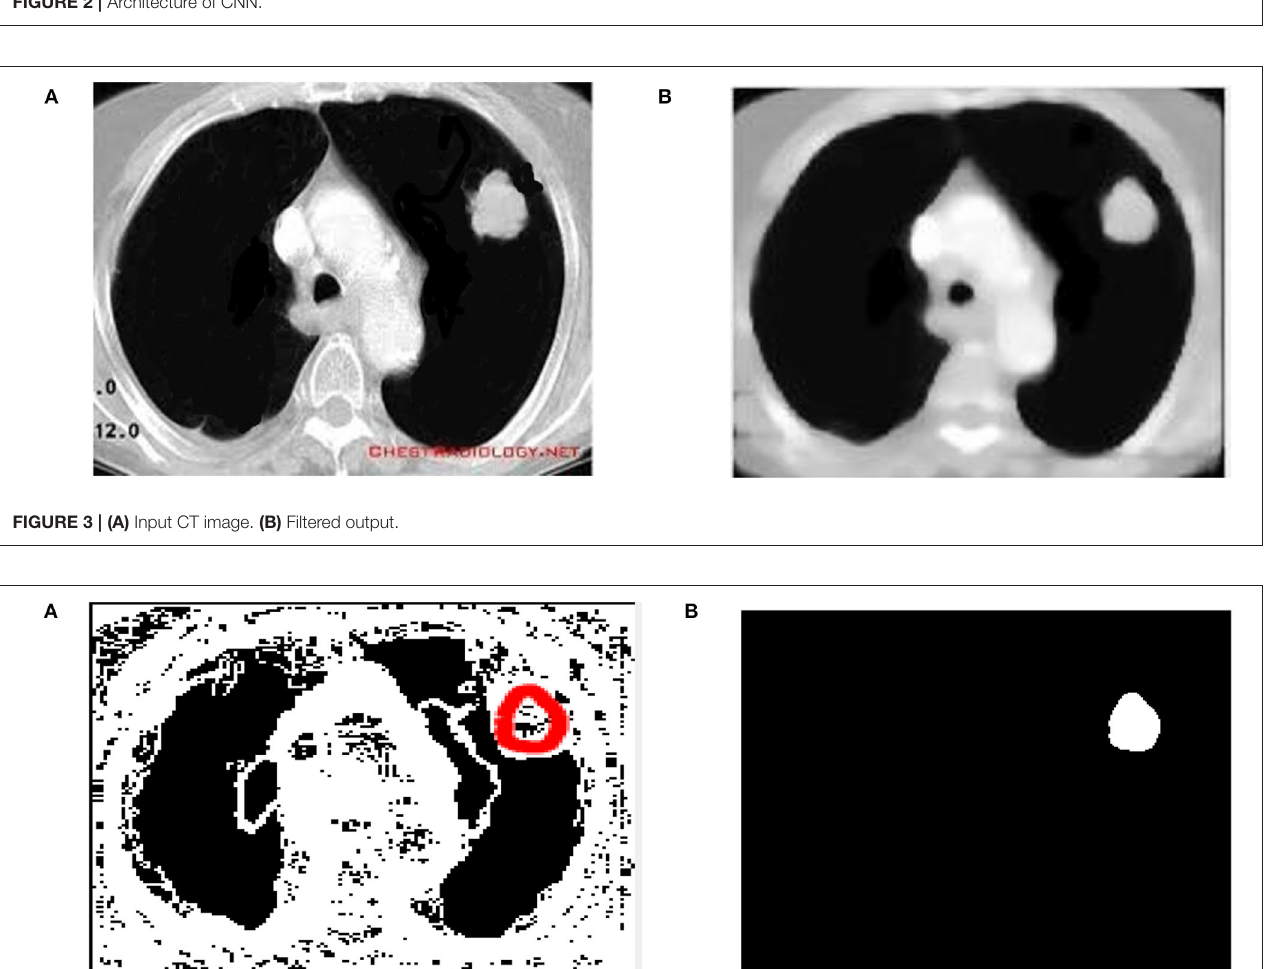
(38). After being portioned, it is placed in the output in the respective position. RELU is a rectified linear unit,